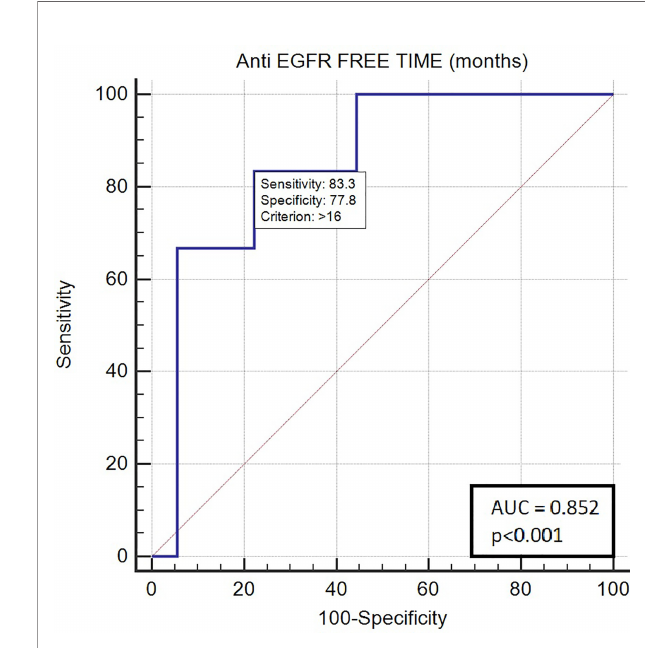
FIGURE 1 | ROC curve of anti-EGFR free-time predictive of prognosis with rechallenge treatment (AUC 0.81, p < 0.001).